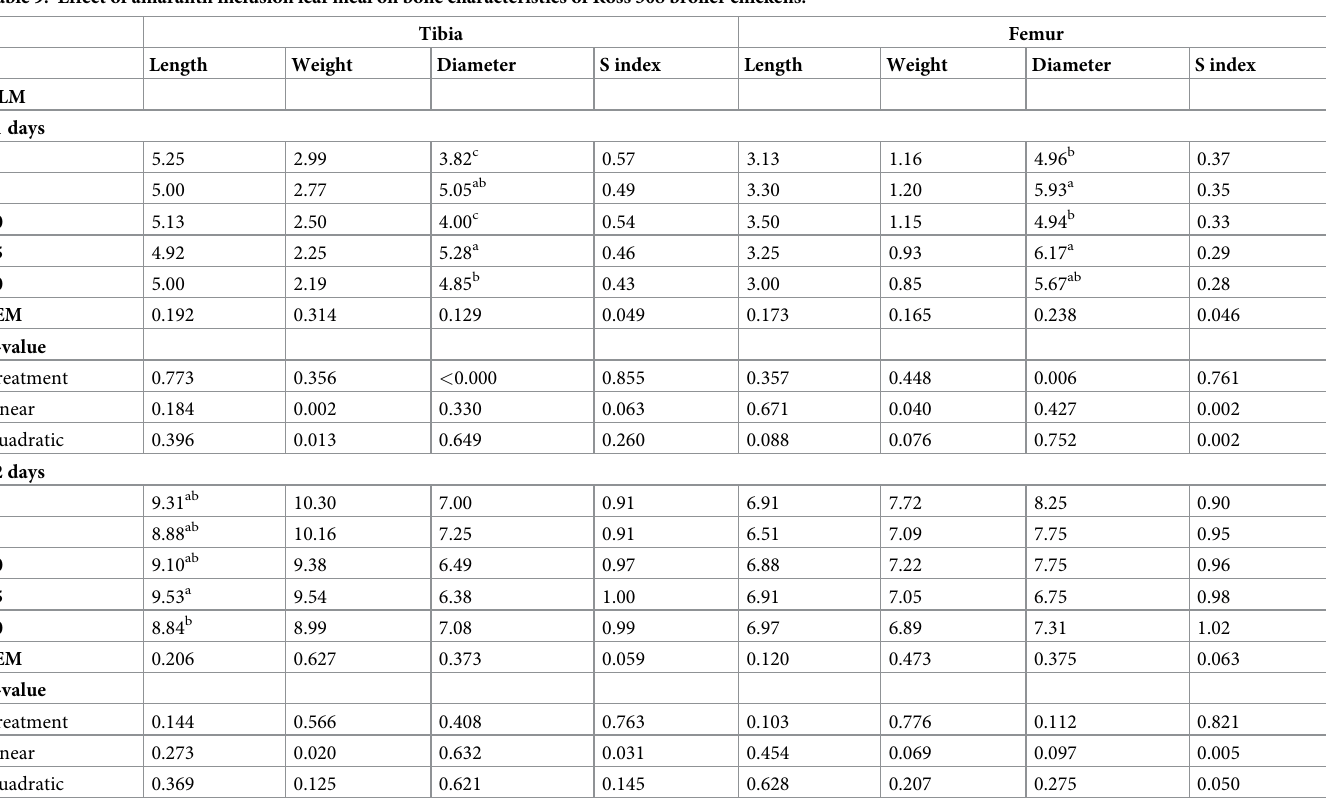
Table 9. Effect of amaranth inclusion leaf meal on bone characteristics of Ross 308 broiler